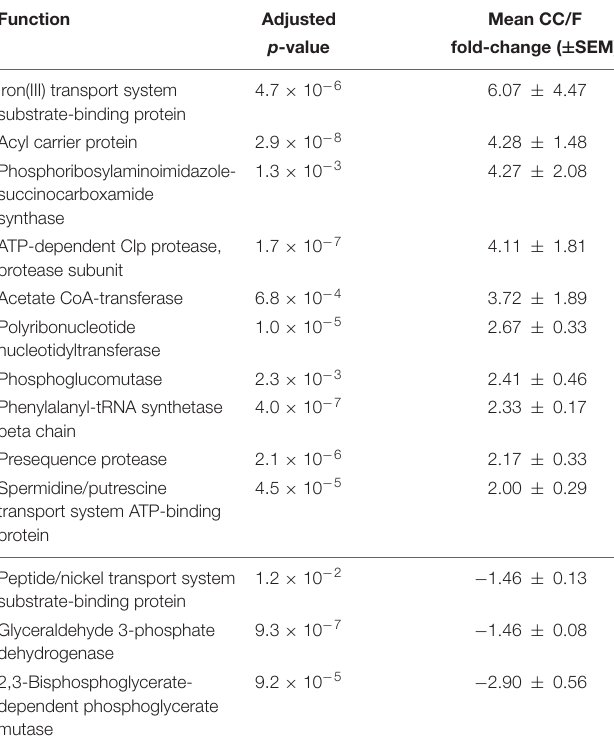
TABLE 3 | Bacteroidetes functions with significantly differential normalized abundance between cecal and fecal